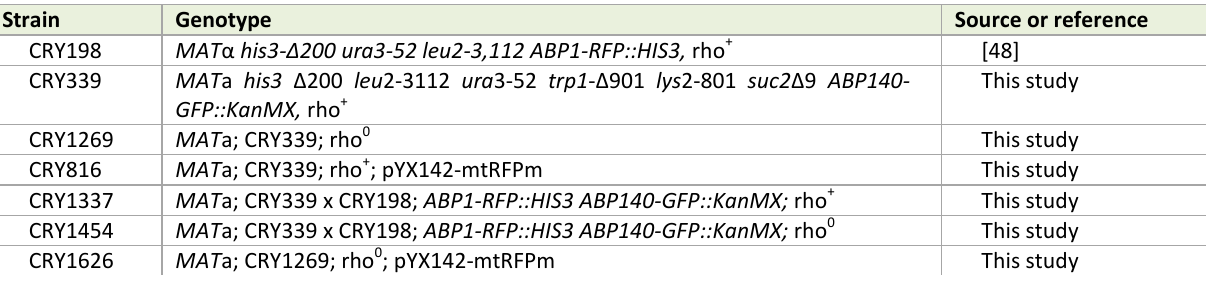
TABLE 1. Yeast strains. Strain Genotype Source or